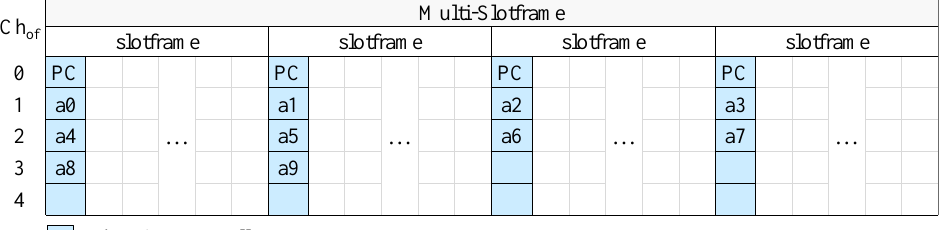
Figure 7. ECFAS using horizontal indexing in the case where, except from the PAN Coordinator (PC), there are 10 other advertisers whose identifiers are consecutive and start from 0, the number of available channels is 5, S = 4 and A s =